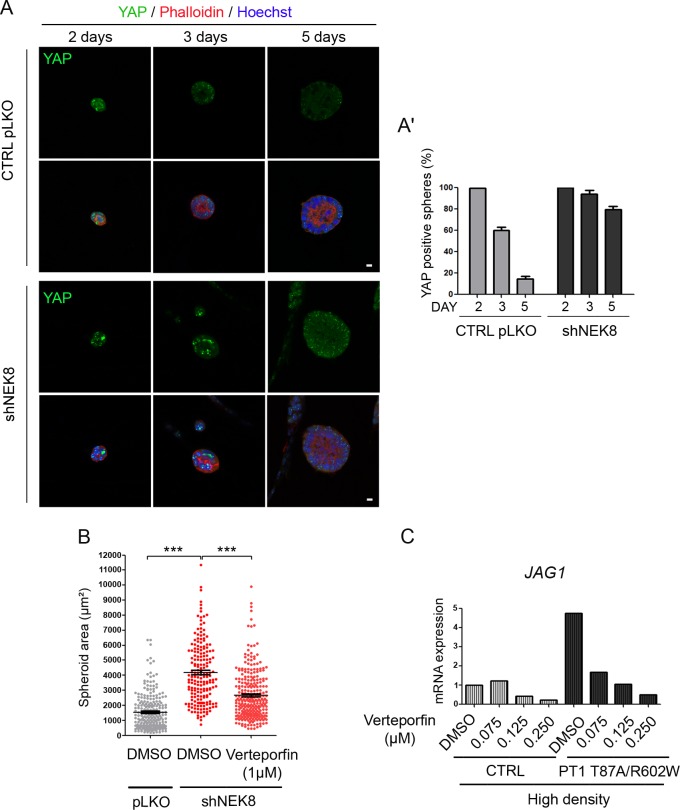
Nuclear YAP persistence in shNEK8 3D spheroids results in morphological and size abnormalities that are rescued by Verteporfin treatment.(A) Three-dimensional (3D) spheroids derived from control pLKO and shNEK8 cells were fixed after 2, 3 and 5 days of culture. Structures were stained for YAP (green), phalloidin (red, F-actin) and nuclei (Hoechst, blue). Equatorial sections of representative spheres are presented, showing that YAP is upregulated in shNEK8 3D spheres. Scale bars, 10 μm. (A’) Quantification of YAP-positive spheres at day 2, 3 and 5. (B) Graph showing the quantification of sphere areas after 5 days of culture, upon DMSO or Verteporfin treatment. Verteporfin treatment reduces the area of the shNEK8 spheroids. The graph indicates the mean +/- SEM. ***p < 0.001, calculated by Student t-test with Welsh correction. (C) qPCR analysis of JAG1 expression in control (CTRL) and patient (PT1) fibroblasts, cultivated at high density and treated with different doses of Verteporfin as indicated. Data show a reduction in the expression of JAG1 in a dose-dependent manner in patient fibroblasts.